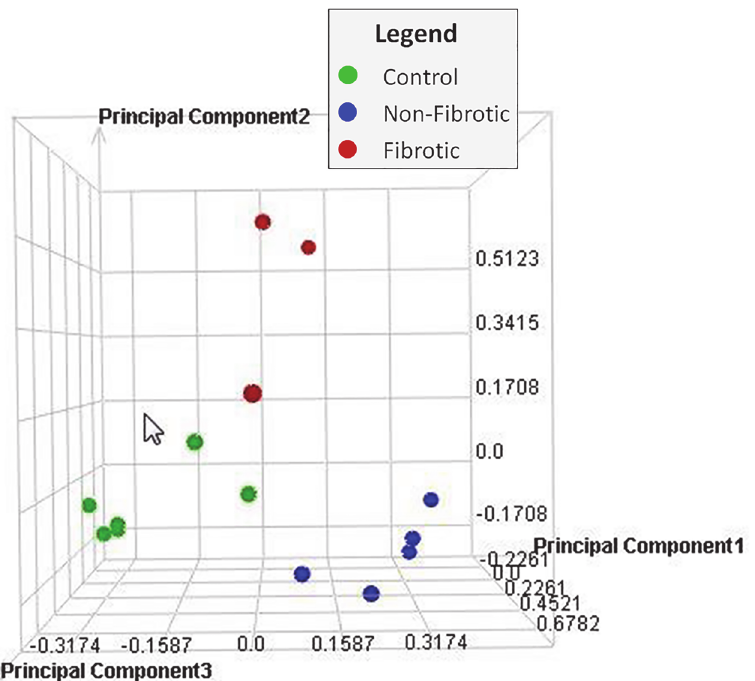
Fig 3. Principal component analysis. Principal Component Analysis (PCA) was performed on all samples and all probes to reduce the dimensionality of the data while preserving the variation in the data set. The PCA indicates that although there is some variability within groups, the samples separate by treatment (air or PD) and sample type (PD-exposed fibrotic; PD-exposed nonfibrotic; air-exposed